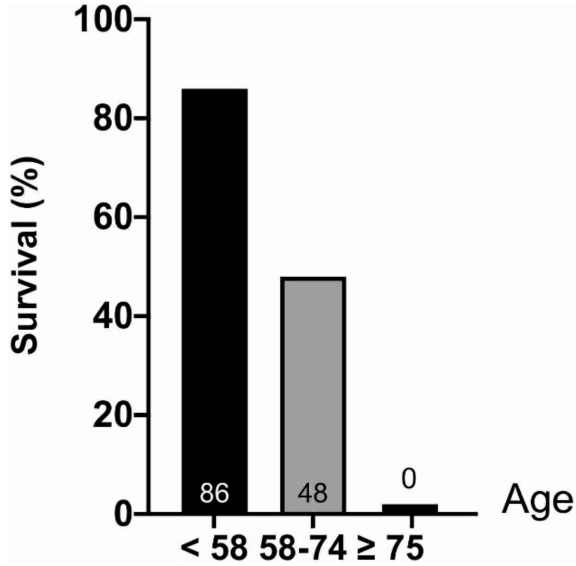
Figure 3. Relationship between age and 30-day survival.